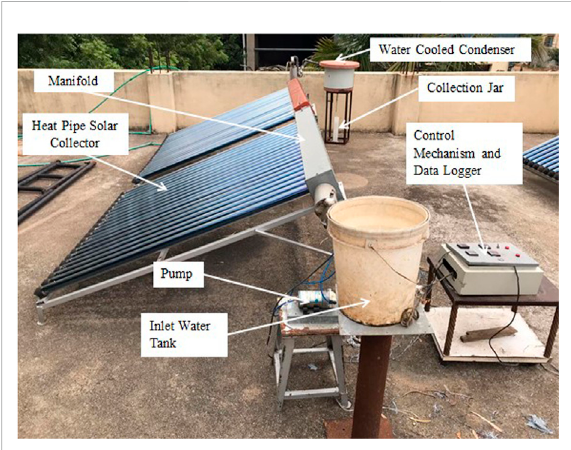
FIGURE 1 Pictorial representation of the evacuated tube solar collector with collective condenser heat pipe solar desalination